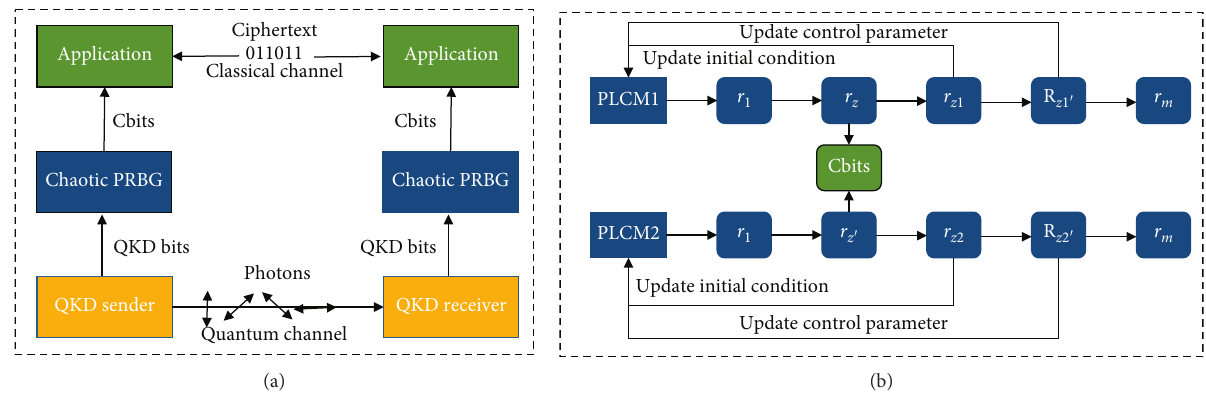
Figure 1: Review of EUQKD. (a) Hierarchical structure of EUQKD. (b) Workflow diagram of the middle